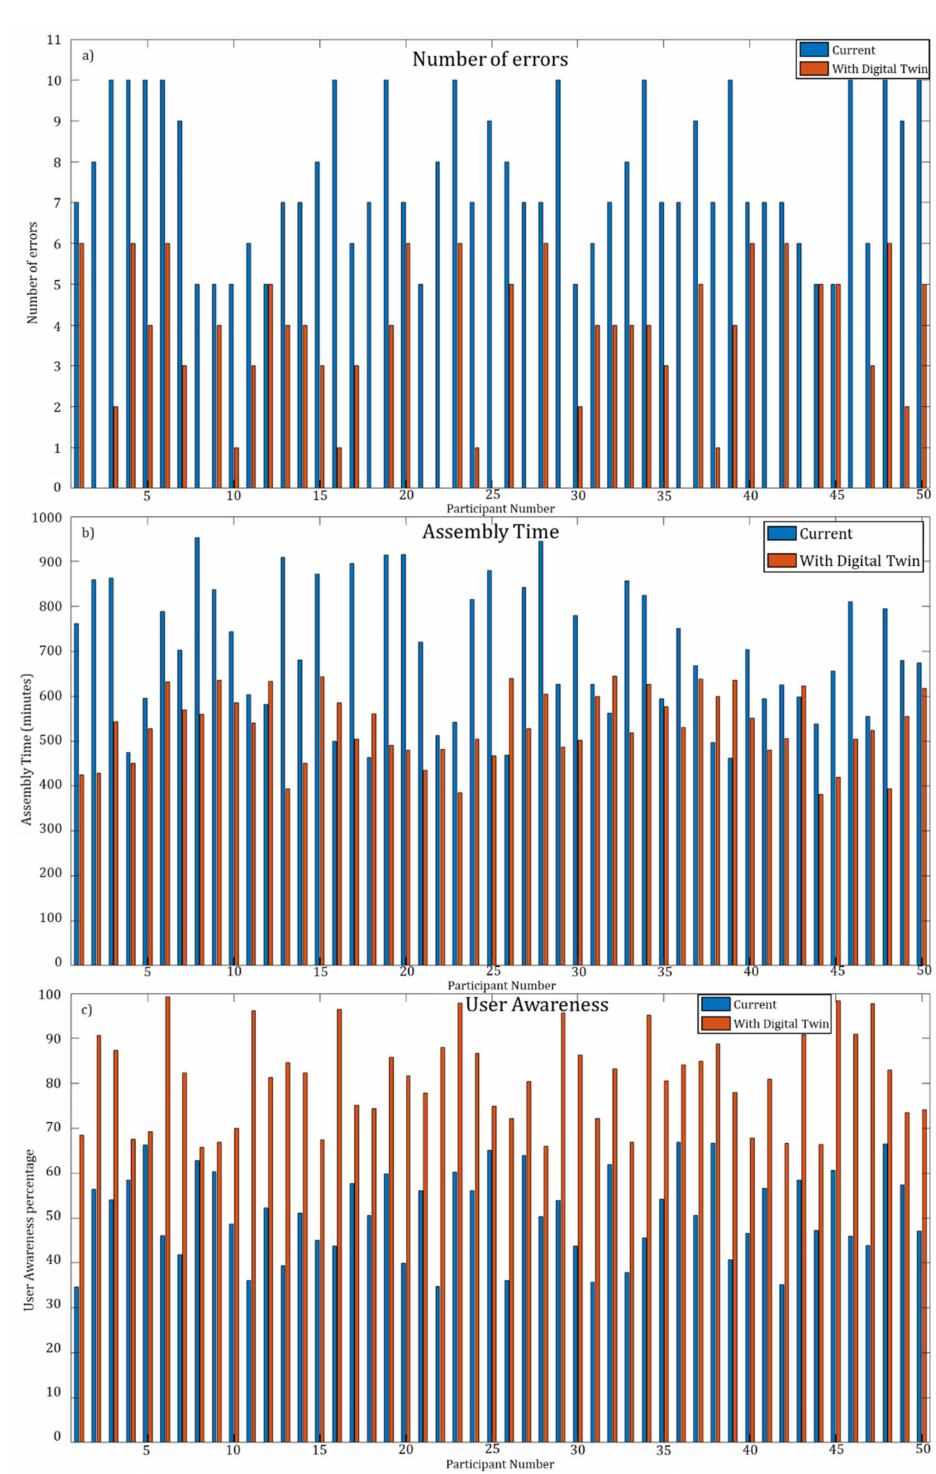
Figure 7. Results: ( a ) number of errors; ( b ) assembly time; ( c ) user